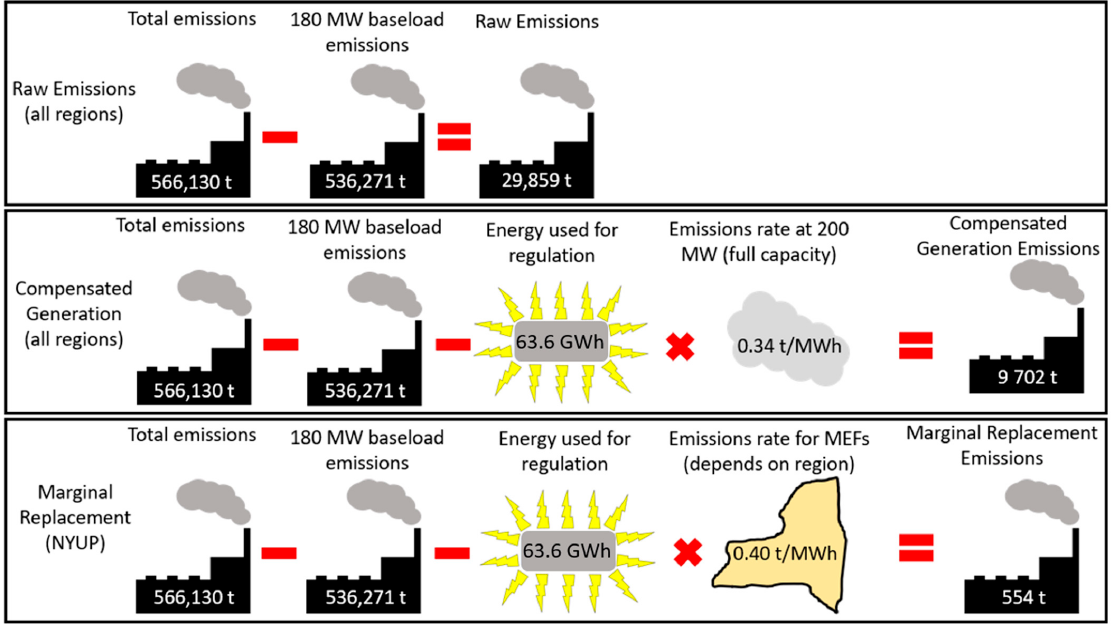
Figure 1. Example of calculations for three methods of estimating annual natural gas CO 2 emissions attributable to frequency regulation. The raw emissions method is the simplest but neglects that the gas turbine produces 63.6 GWh of energy annually in association with the regulation service. The compensated generation case credits those emissions at the full capacity emissions rate for the gas turbine. The marginal replacement method credits those MWhs at the marginal emissions rate for the electricity grid. Upstate New York (NYUP) was used as an example since there are different marginal emissions in each